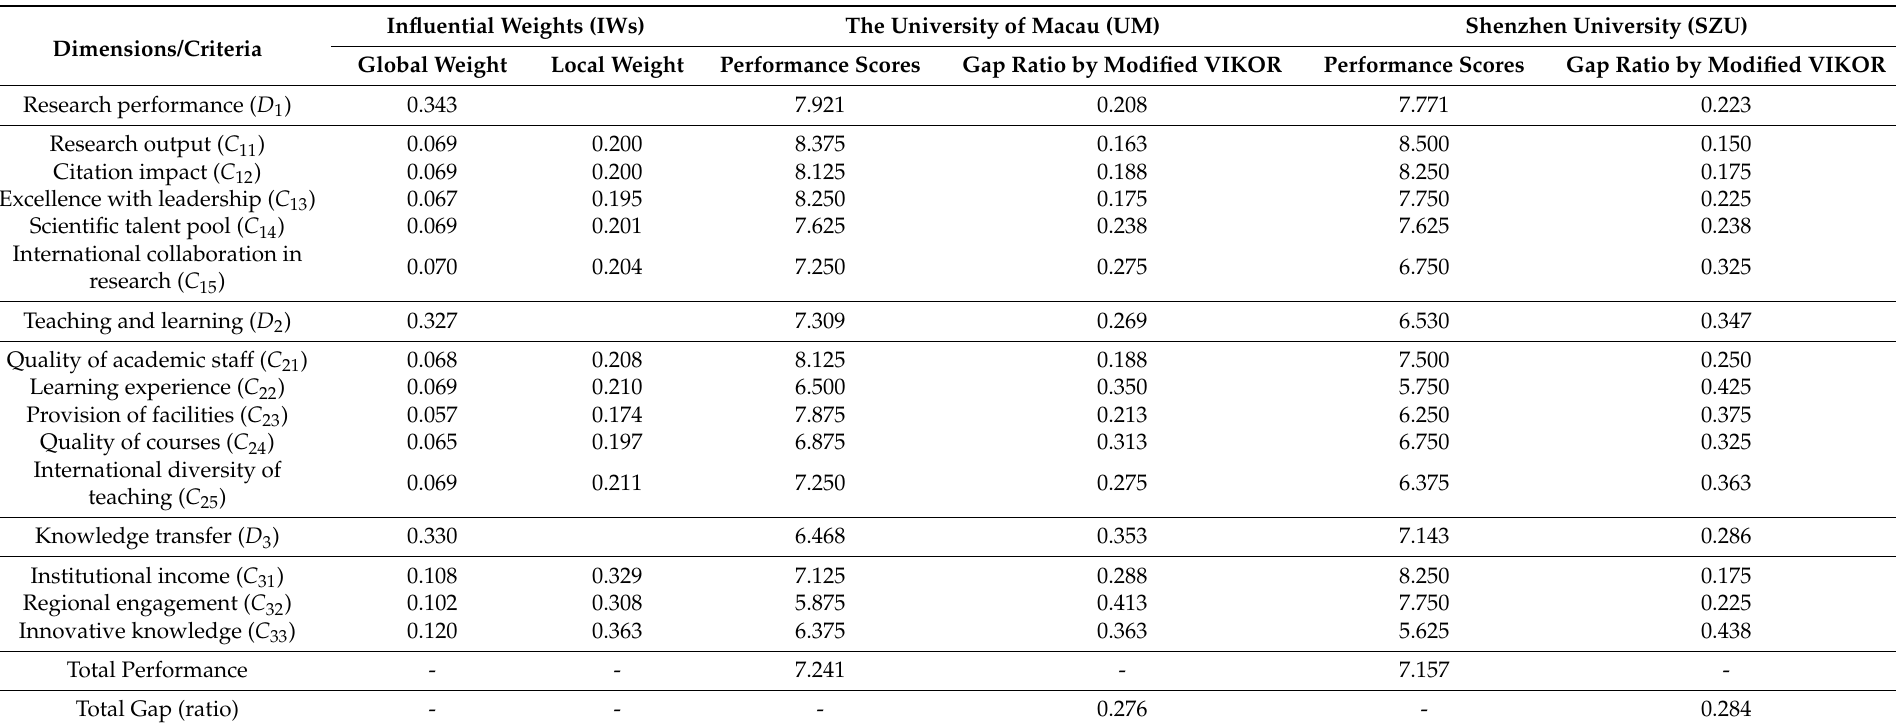
Table 3. Performance evaluation of the University of Macau (UM) and Shenzhen University (SZU) based on the DEMATEL-based analytic network process (DANP) and